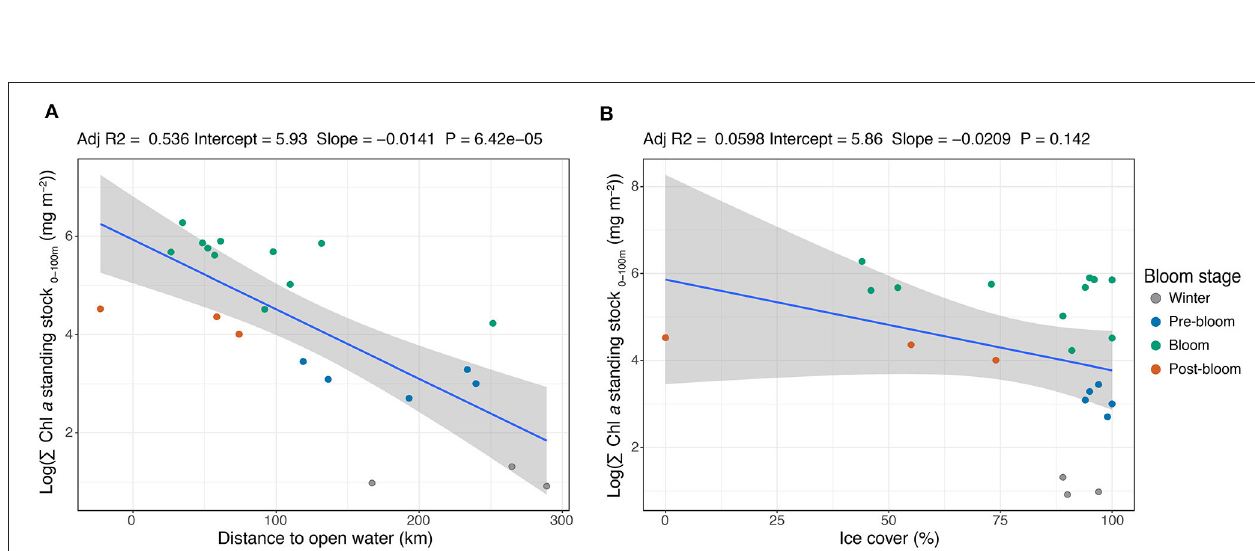
Frontiers in Marine Science |